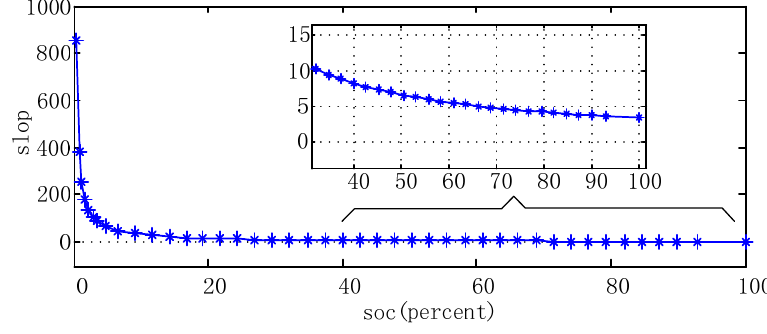
Figure 5. Slope of the linearized SOC-OCV curve.